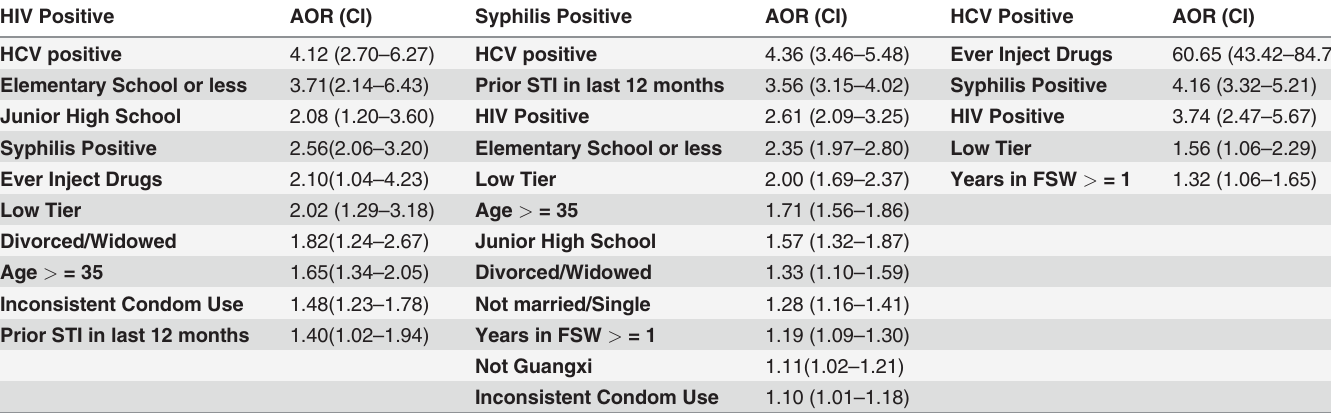
Table 5. Multivariate models of correlates of the outcomes of testing positive for HIV, HCV, and syphilis among female sex workers (FSWs) in Guangxi Province, China, China National CDC HIV/AIDS Surveillance Data, 2010 – 2012,N = 51,790. HIV